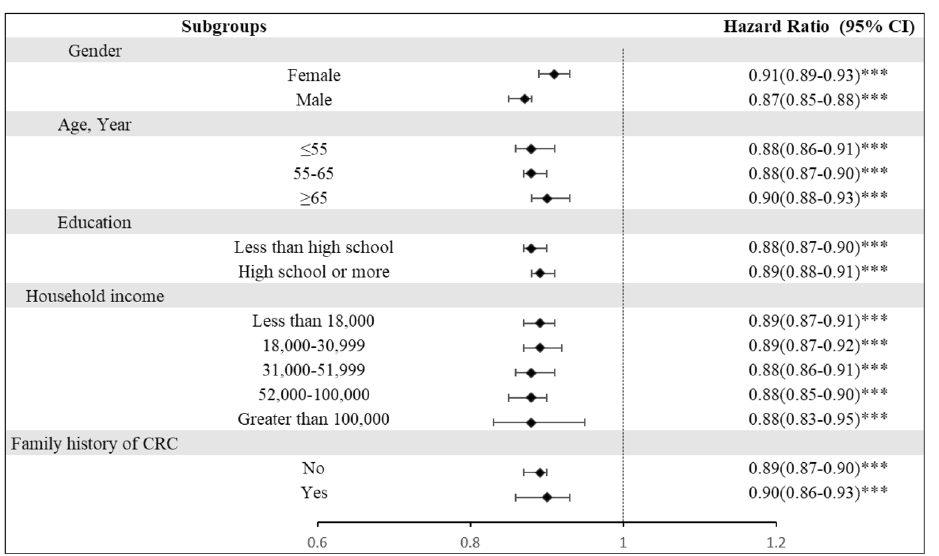
Figure 2. Hazard ratio (95% CI) of CRC events per 1-number increment in combined score among participants. Combined score: the sum of lifestyle score and sleep score; hazard ratios (95% CI) were adjusted for age, sex, education, household income, family history of